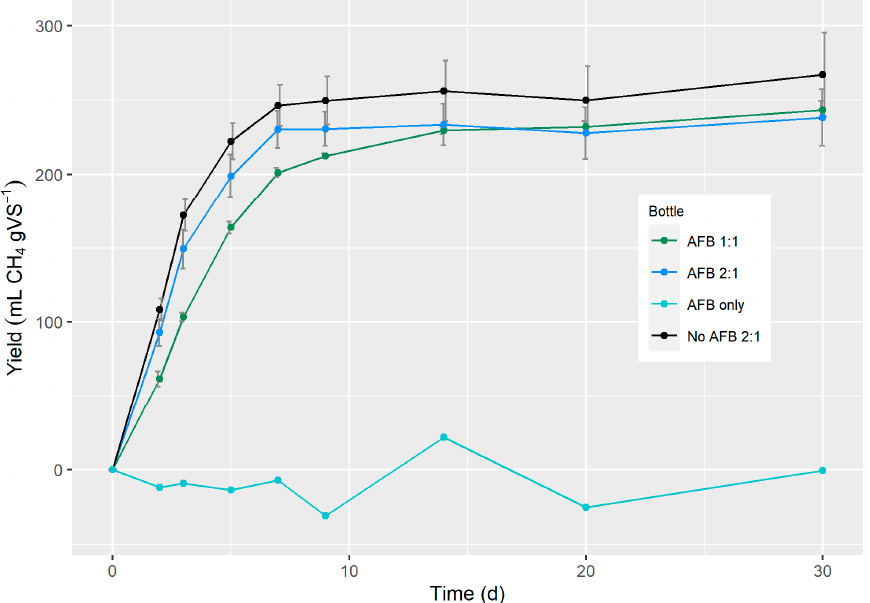
Figure 1. Comparison of specific methane yields with/without the AFB technique. The yield over time is shown for CGP. Error bars show standard deviation ( n = 3). Only one replicate was made for AFB only.